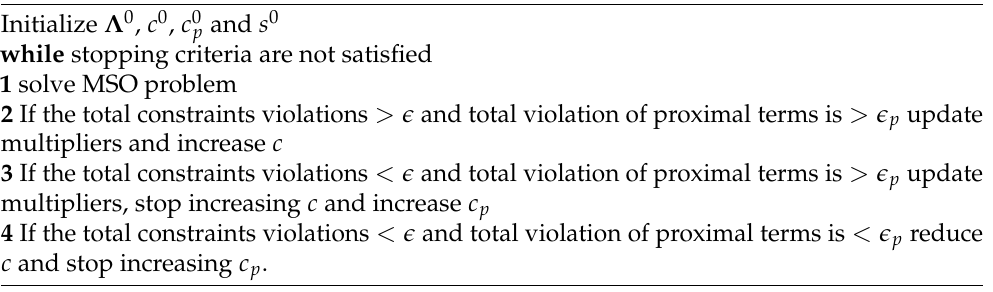
Algorithm 1 Surrogate Lagrangian Relaxation.